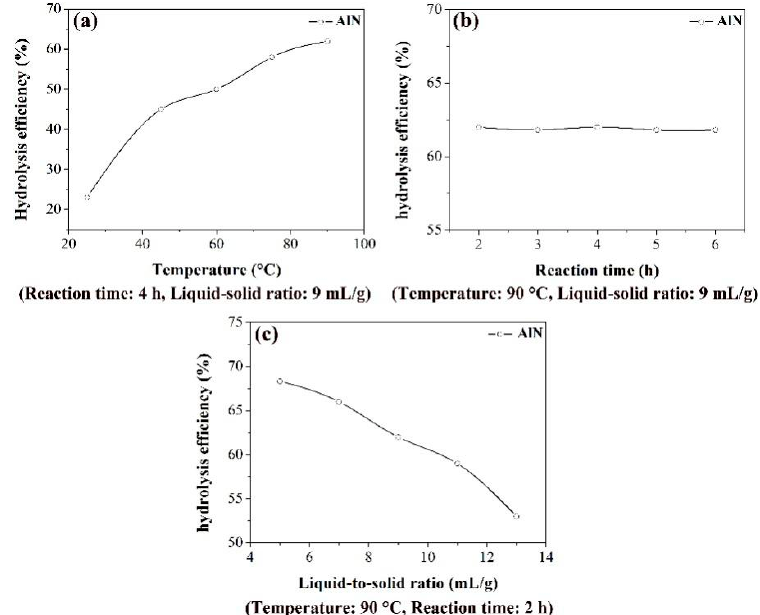
Figure 3. Effects of temperature ( a ), reaction time ( b ), and liquid-to-solid ratio ( c ) on the hydrolysis efficiency of AlN.